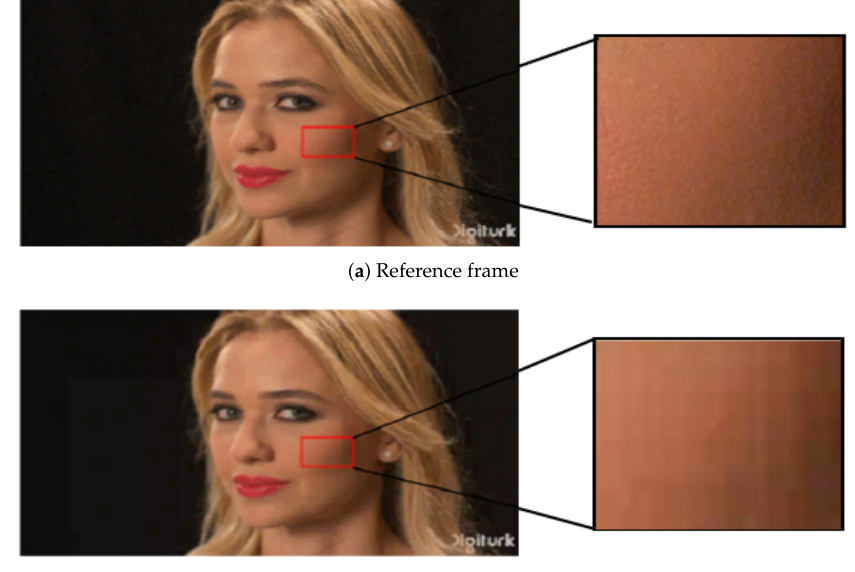
Figure 3. An example of blocking [27]. (3) Ringing: When the quantization error of the high-frequency component corre- sponding to strong edges of image occurs, a corrugated pseudo-boundary will